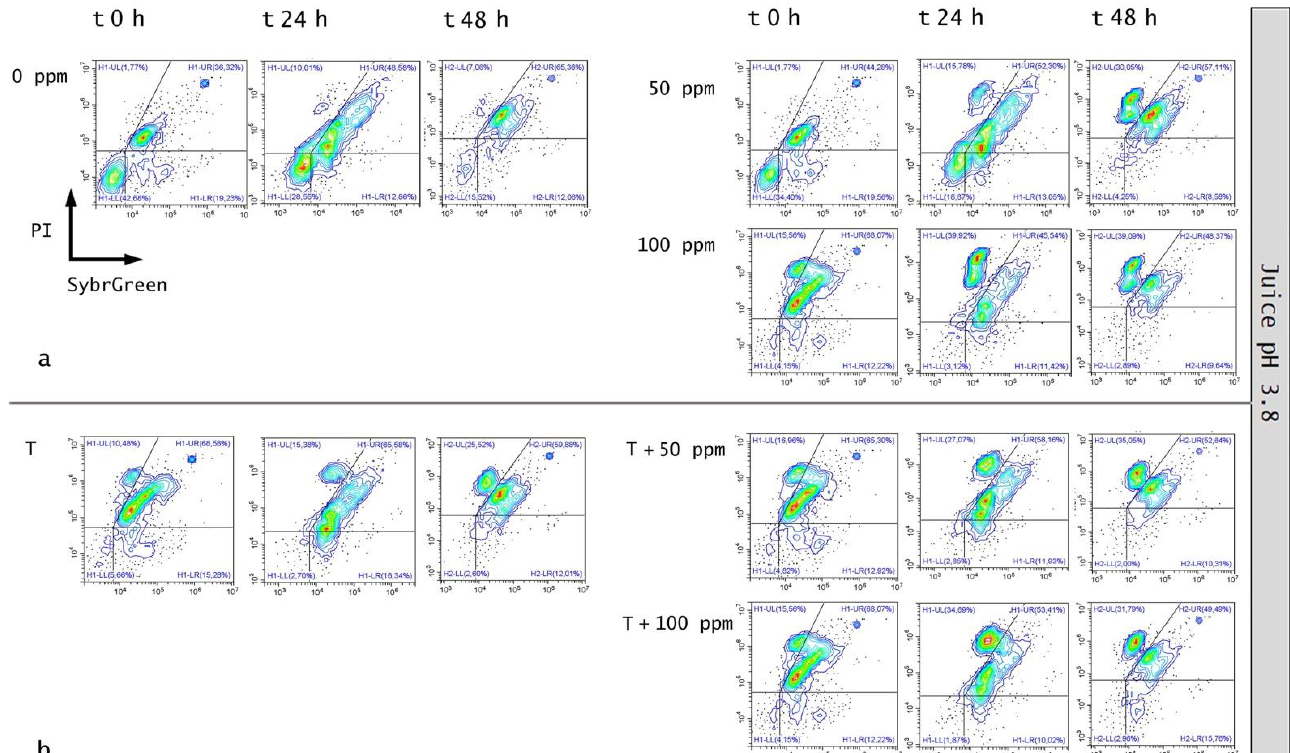
Figure 10. Double-staining density dot plot of E. coli cells in fruit juice (pH 3.8) diluted in PBS (pH 7.4): ( a ) 50 ppm and 100 ppm essential oil treatment and ( b ) combined thermal treatment at 65 °C with or without OEO at 0, 24 and 48 h of incubation. Cells were stained with SYBR-Green I and PI simultaneously. H1-LL: unstained debris; H1-LR: intact cells/viable cells; H1-UR: injured cell population; H1-UL: permeabilized/dead cells. In the upper right side of the plot, a defined single population represents standard beads.